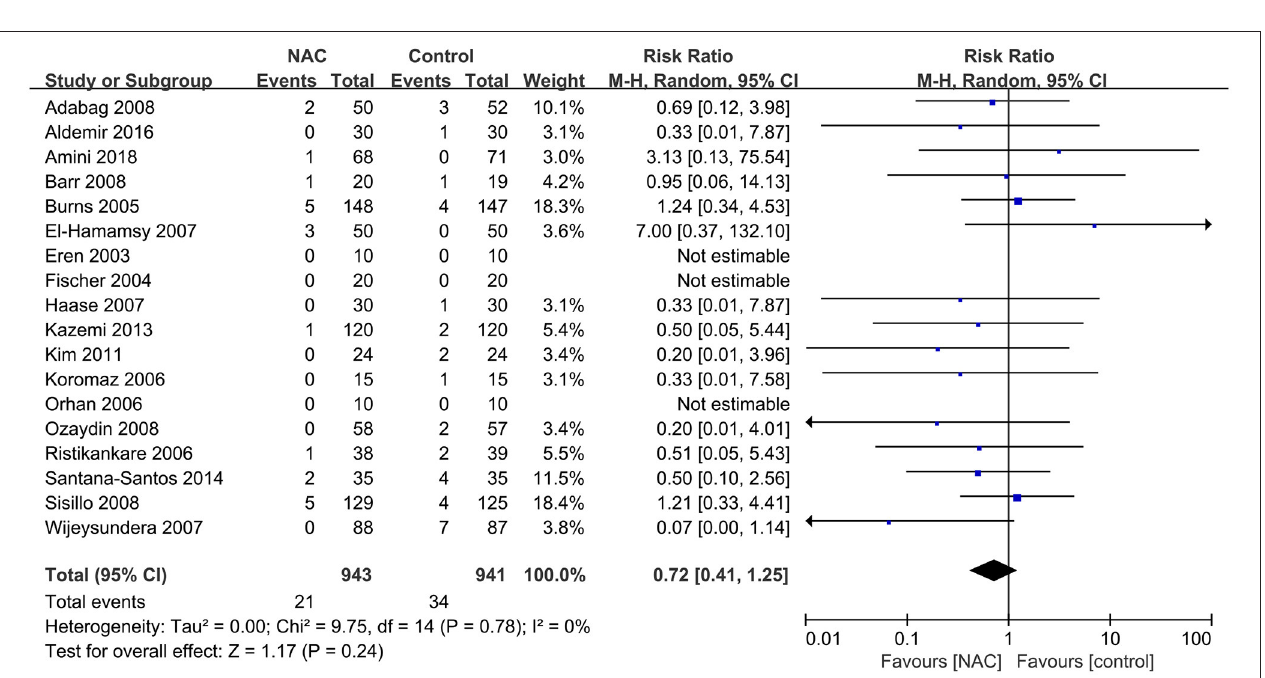
FIGURE 4 | Forest plot of the effects of NAC on the need of patients for RRT after surgery.